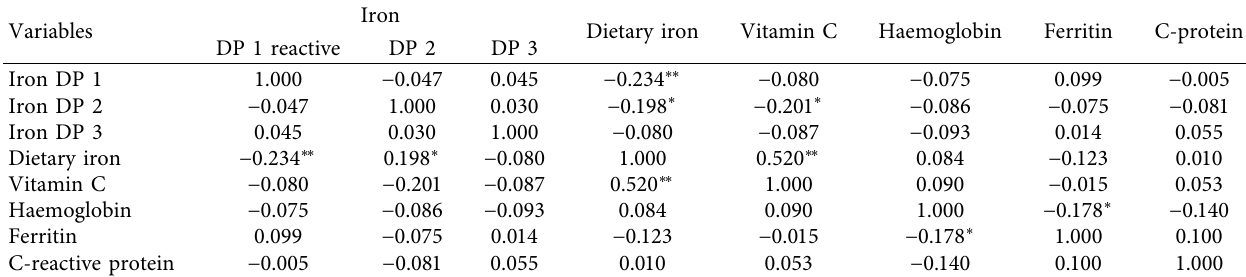
Table 4: Partial correlation of iron dietary pattern (IDP) and biochemical markers.